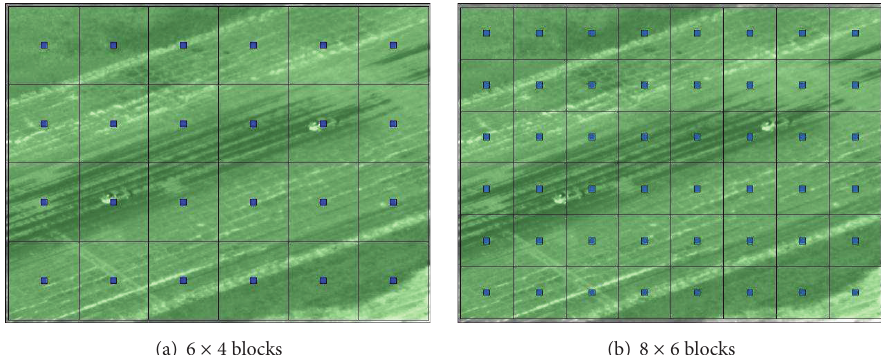
Figure 2: Positions of template blocks (blue) and search areas (green) in video frame for different densities ( 𝑚 × 𝑛 ) of block matching with same hardware cost.